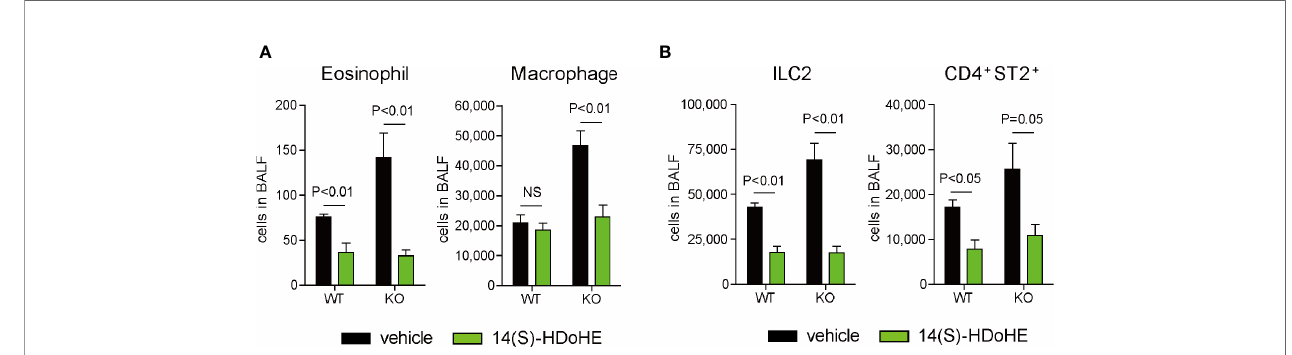
FIGURE 5 | 14(S)-HDoHE suppresses IL-33-induced airway eosinophilic in fl ammation. Airway in fl ammation was induced by administration of IL-33 (500 ng per mouse, intranasal), for 3 consecutive days, in C57BL/6 and 12/15-lipoxygenase de fi cient mice. 14(S)-hydroxy docosahexaenoic acid (HDoHE) was administered via intraperitoneal injection prior to IL-33 administration. Flow cytometric analysis was performed 4 days after the fi nal administration of IL-33. (A) Number of eosinophils and macrophages in the BALF. (B) Number of lymphocyte subsets, including ILC2 and Th2 cells, in the BALF. Mean ± SEM, n=4 for each group. NS, not signi